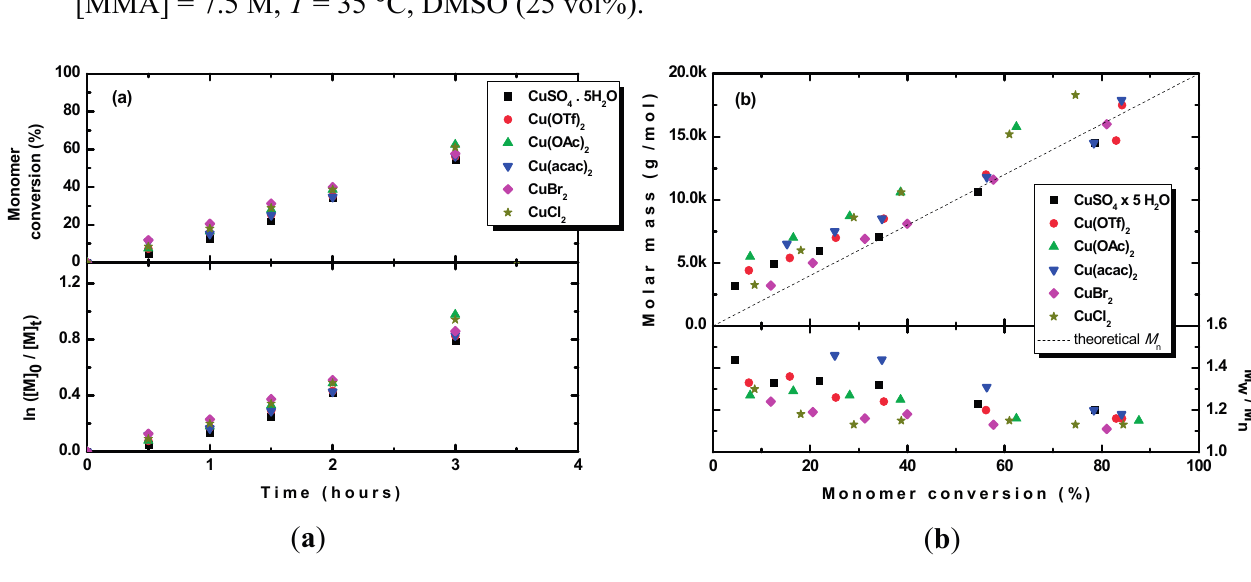
Figure 6. ( a ) Kinetic plots and ( b ) evolution of the molar mass and M w / M n with the conversion of MMA during photoRDRP using various copper catalysts. BPN and TPMA were used as the initiator and ligand, respectively. Experimental conditions: photoRDRP, MMA/BPN/Cu II /TPMA = 200/1/0.04/0.16, irradiation at λ > 350 nm; in all experiments: [MMA] = 7.5 M, T = 35 °C, DMSO (25 vol%).